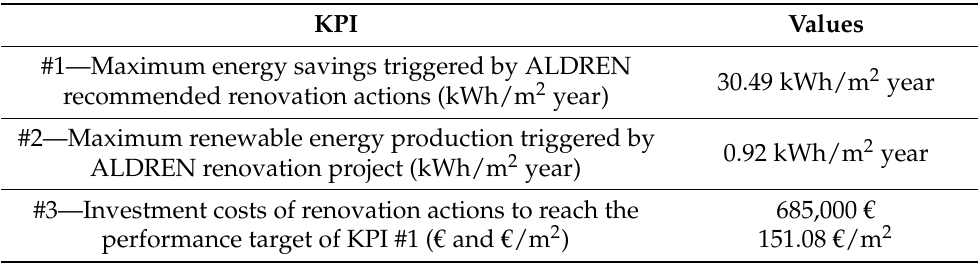
Table 12. ALDREN KPIs results of the Italian case with the RenoMap full packages application.